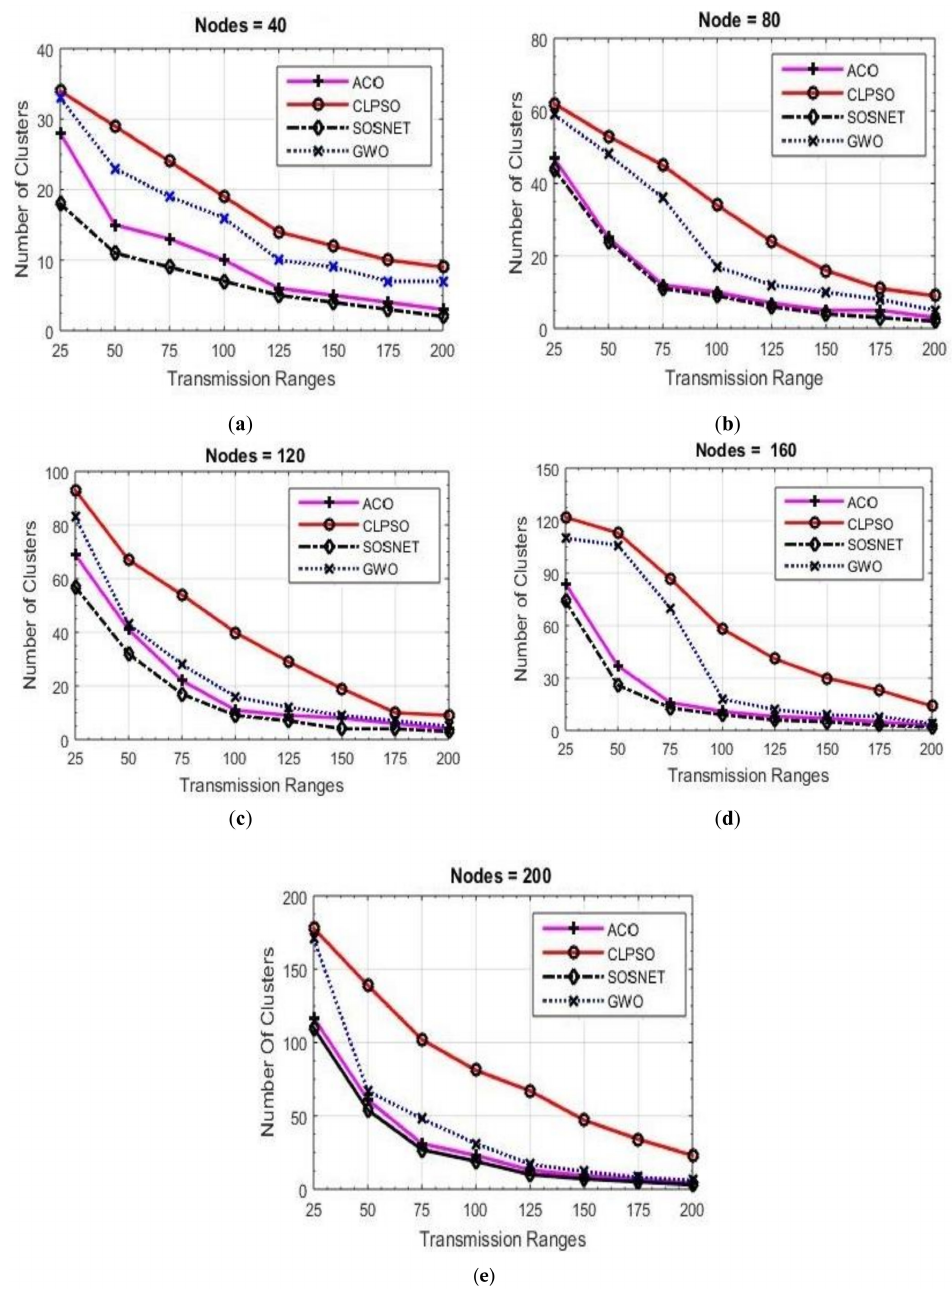
Figure 3. Grid size 500 m × 500 m, nodes 40 to